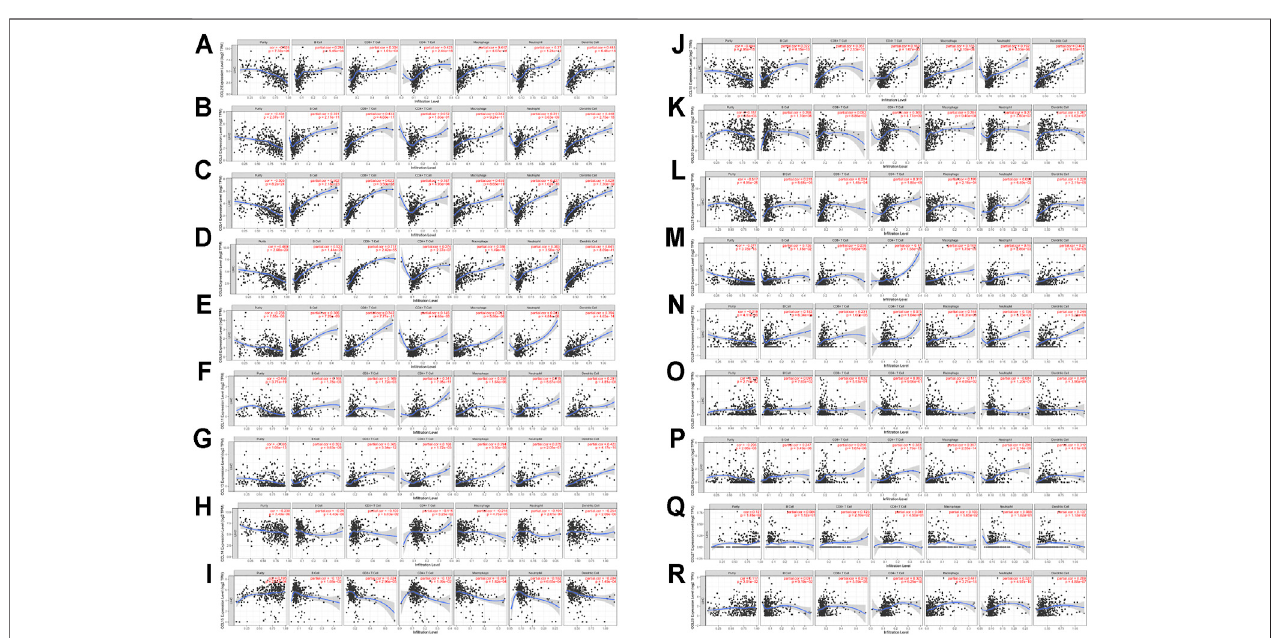
FIGURE5| ThecorrelationbetweenaberrantlyexpressedchemokinesCCLandimmunecellin fi ltration(TIMER).Thecorrelationbetweenthenumerousofimmune cell and the expression of (A) CCL2, (B) CCL3, (C) CCL4, (D) CCL5, (E) CCL8, (F) CCL11, (G) CCL13, (H) CCL14, (I) CCL15, (J) CCL18, (K) CCL20, (L) CCL21, (M) CCL23, (N) CCL24, and (O) CCL25, (P) CCL26, (Q) CCL27, and (R) CCL28 in LIHC.